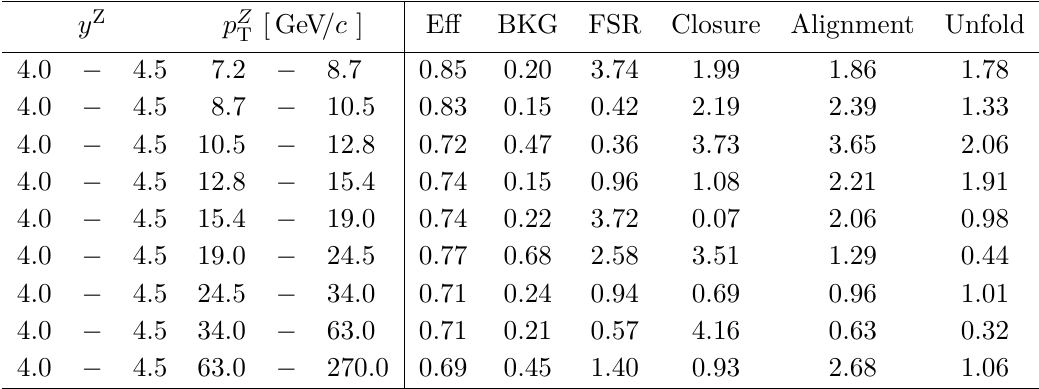
Table 22. Systematic uncertainties in the double differential cross-sections in interval regions of y Z and p Z , presented in percentage. The contributions from efficiency (Eff), background (BKG), final T state radiation (FSR), closure test (Closure), unfolding (Unfold), and alignment and calibration (Alignment) are